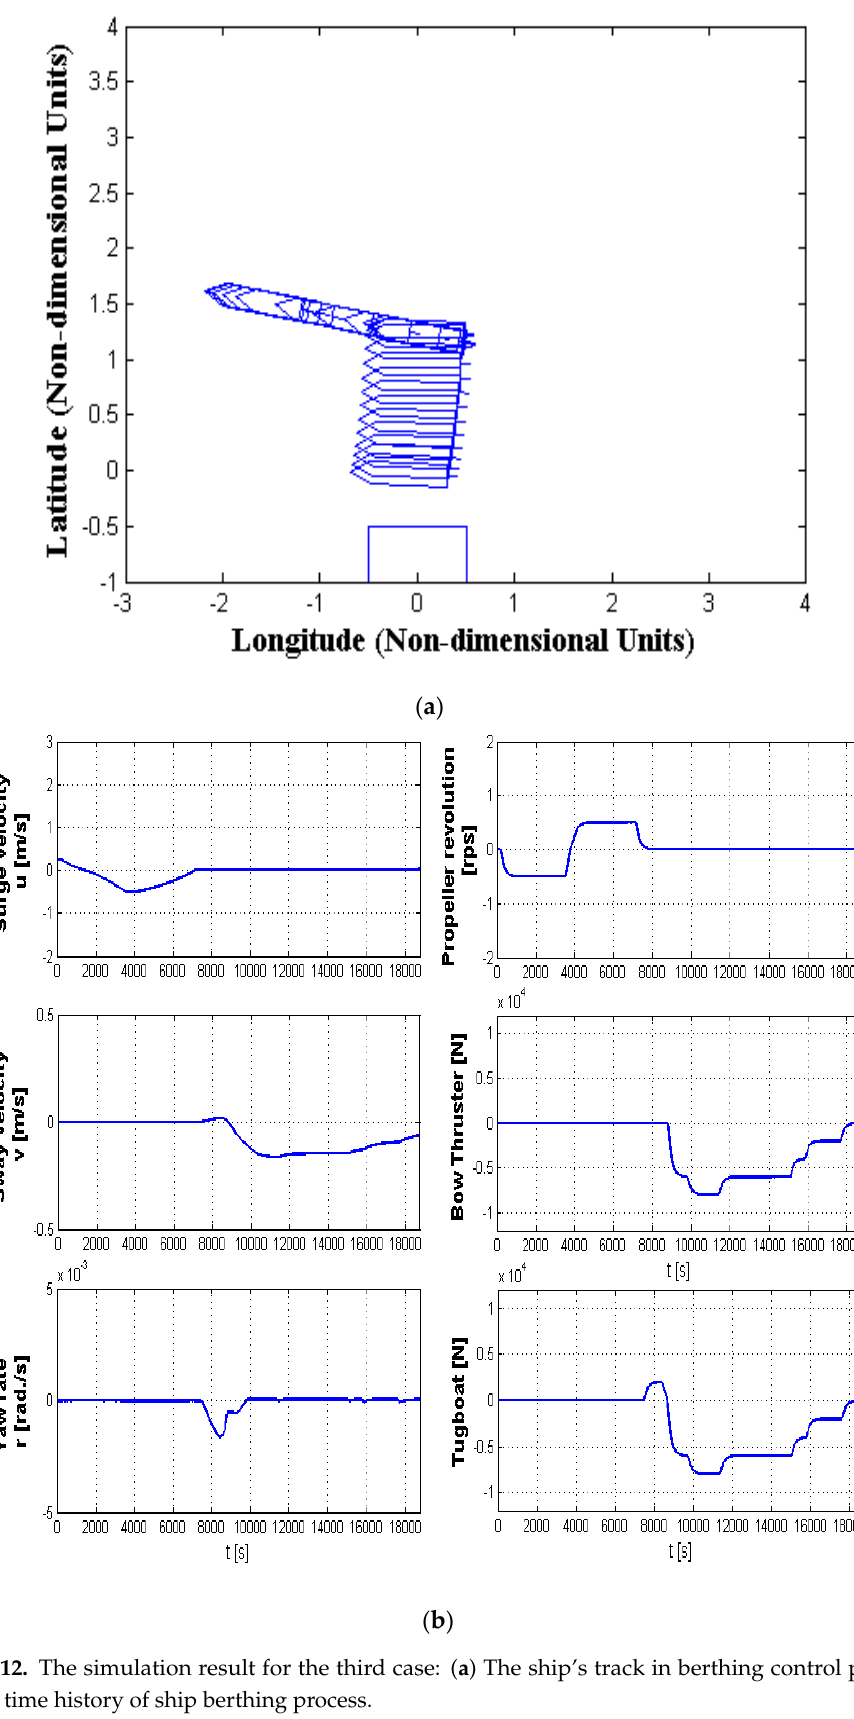
Figure 12. The simulation result for the third case: ( a ) The ship’s track in berthing control process; ( b ) The time history of ship berthing process.